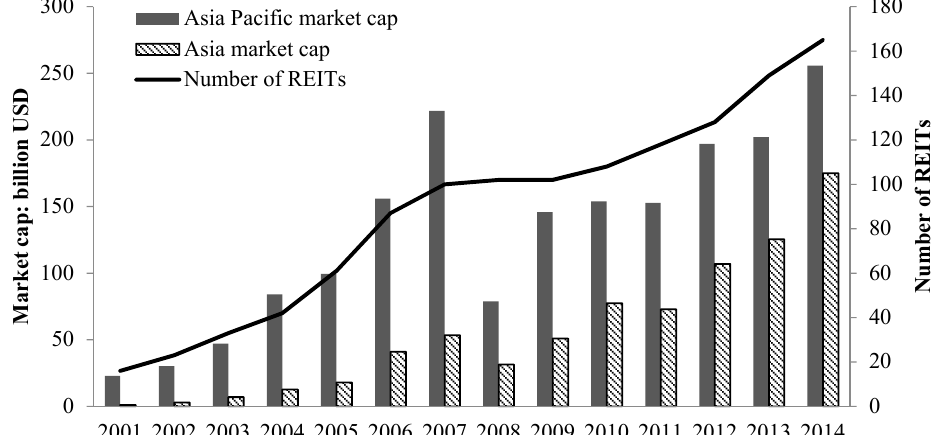
Figure 1. Real estate investment trust (REIT) market growth in the Asia Pacific region.